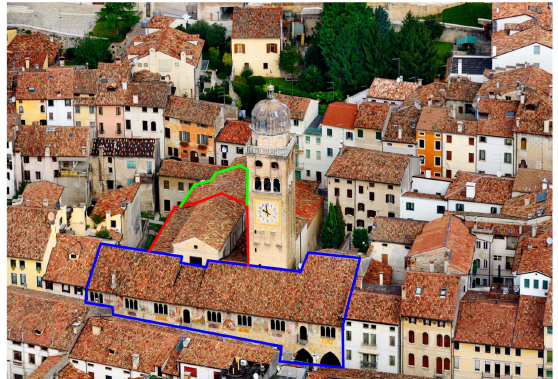
Figure 9. A view of the Dome of Conegliano from above. Blue outline: Battuti’s meeting room. Red outline: the former volume of the church. Green outline: the added volume in 1491. The bell tower (1497) is also present.